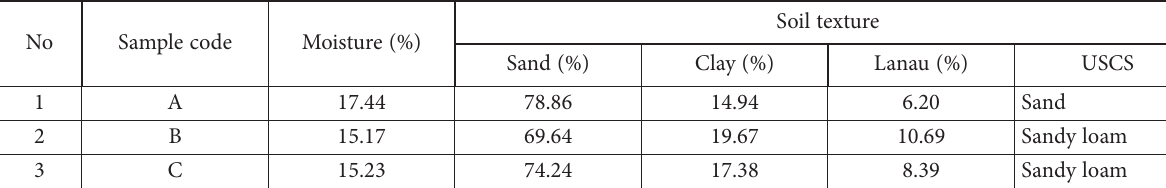
Table 3. Properties of soil samples (source: Laboratory Test, 2021) No